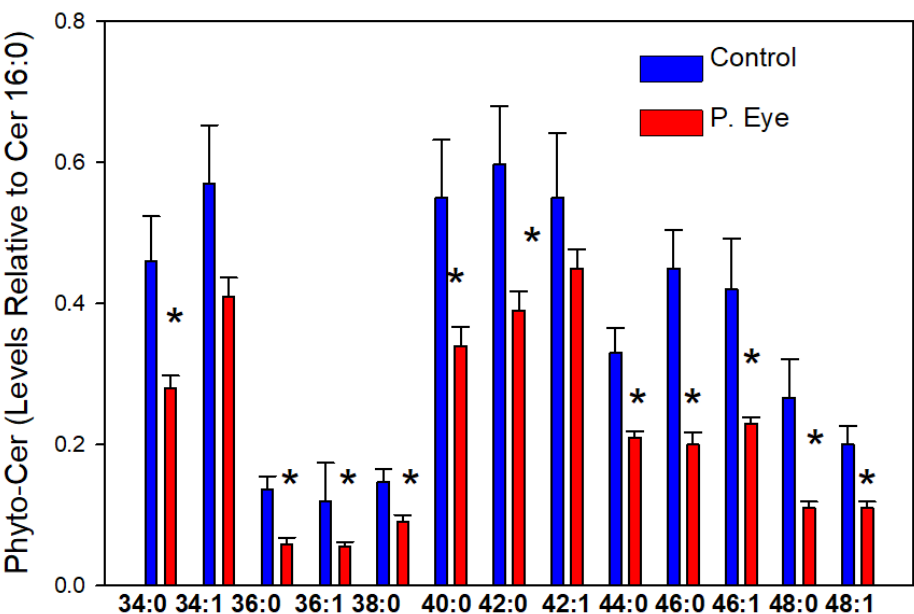
Figure 3. Tear film levels of phytoceramides (Phyto-Cer) in controls and cows with pink eye (P. Eye). The peak intensities of individual phytoceramides are expressed as a ratio of the peak intensity of